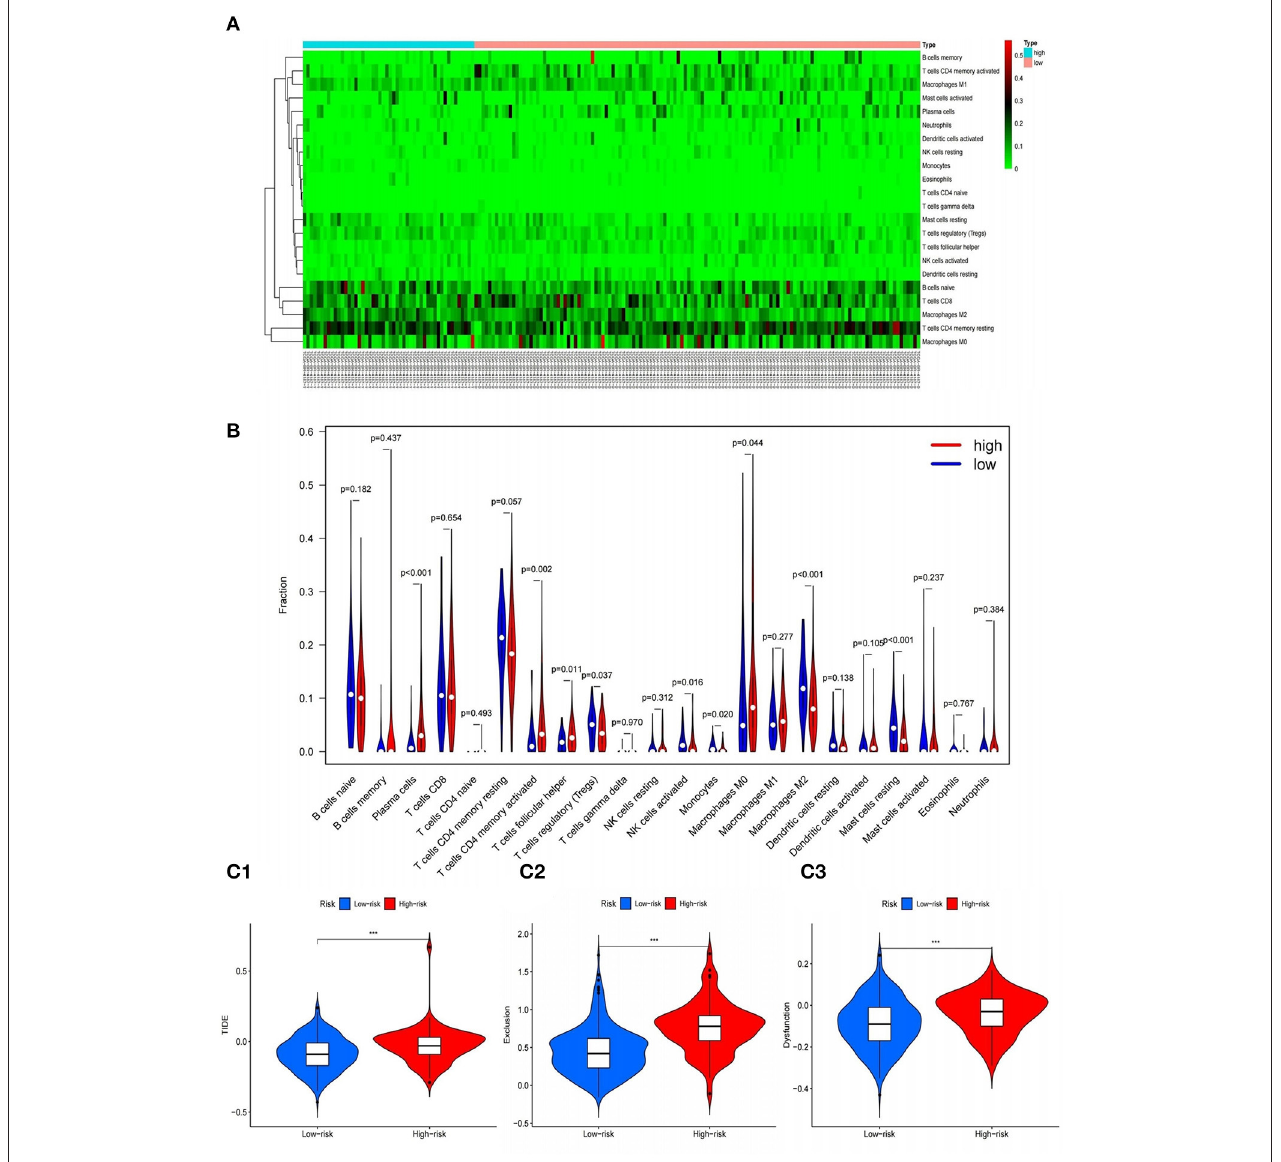
FIGURE 11 | Correlation of gene model with immune cell infiltration and immunotherapy. (A,B) Heat and violin plots of differences in immune cell infiltration in high and low risk groups. (C1–C3) Violin plots of differences in TIDE between high and low risk groups. *** P <